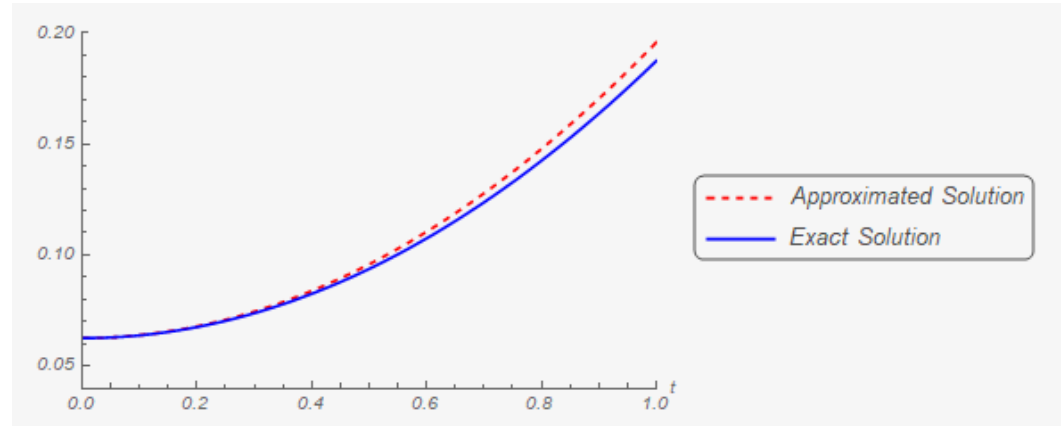
Figure 7. The first component of the exact solution and its one hundred and fifth approximation.